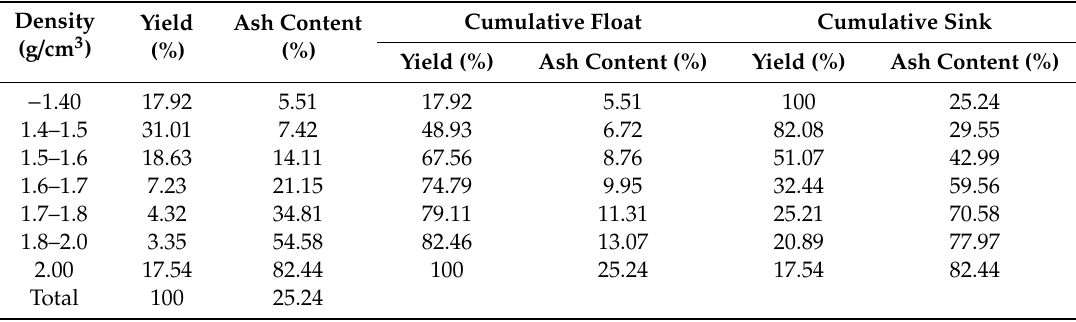
Table 2. Results of sink-float test for − 6 + 1 mm